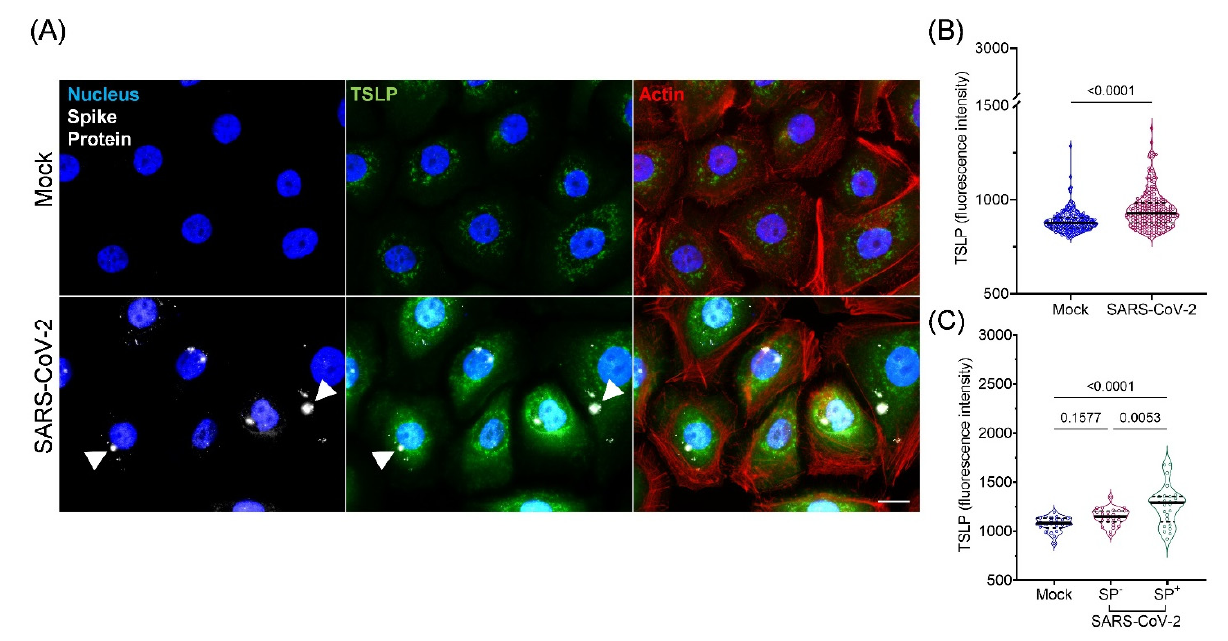
Figure 4. Infection of cultured normal human bronchial epithelial cells (NHBE) with SARS-CoV-2 leads to increased intracellular TSLP. ( A ) NHBE cells were incubated with mock or SARS-CoV-2 (MOI 1) for 24 h. Cells were fixed, permeabilized, and labeled for nucleus (blue), SARS-CoV-2 SP (white), TSLP (green), and actin cytoskeleton (red). Arrowheads indicate punctated regions of SP immunoreactivity. ( B ) Intracellular fluorescent intensity of TSLP in cells, quantified using Volocity software. Each point represents a single cell ( n = 190 for Mock, n = 202 for SARS-CoV-2-infected). ( C ) Fluorescence intensity of TSLP in mock- and SARS-CoV-2-infected cells expressing no detectable levels of SP (SP − ) compared to cells with detectable SP (SP + ) in the SARS-CoV-2 population ( n = 22 for Mock SP − , n = 27 for SARS-CoV-2 SP − , n = 25 for SARS-CoV-2 SP + ). Results shown are representative of 8 separate experiments. Data are presented as individual cells (dots), median (solid line), interquartile range (dotted line) and kernel density (violin). Mann–Whitney and Kruskal–Wallis were used to compare fluorescence in ( B , C ), respectively. Scale bar represents 10 μ m.